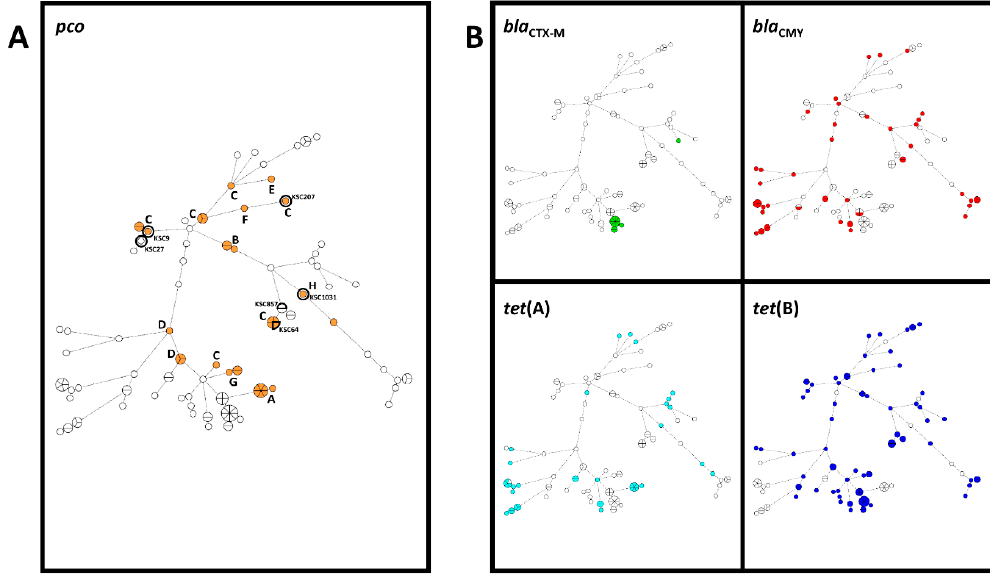
Figure 1. Minimum spanning tree of 116 Escherichia coli isolates, using core-genome multilocus